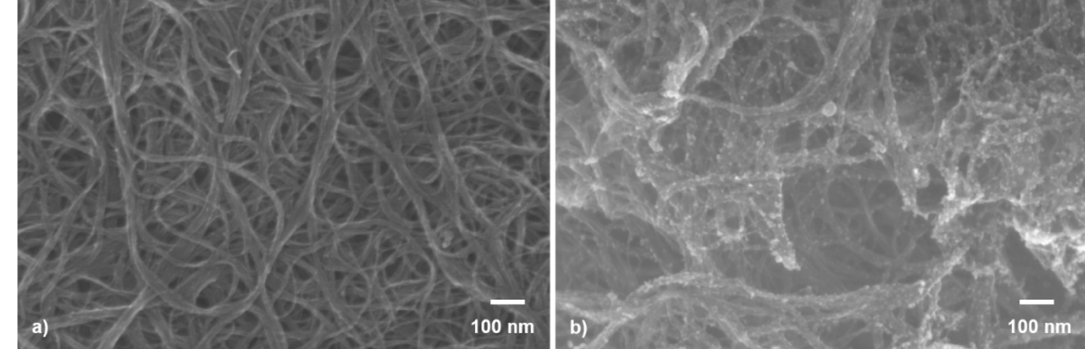
Figure 2. Representative SEM images of ( a ) SWCNT and ( b ) SWCNT@SnO 2 donors, as fabricated prior to laser transfer.